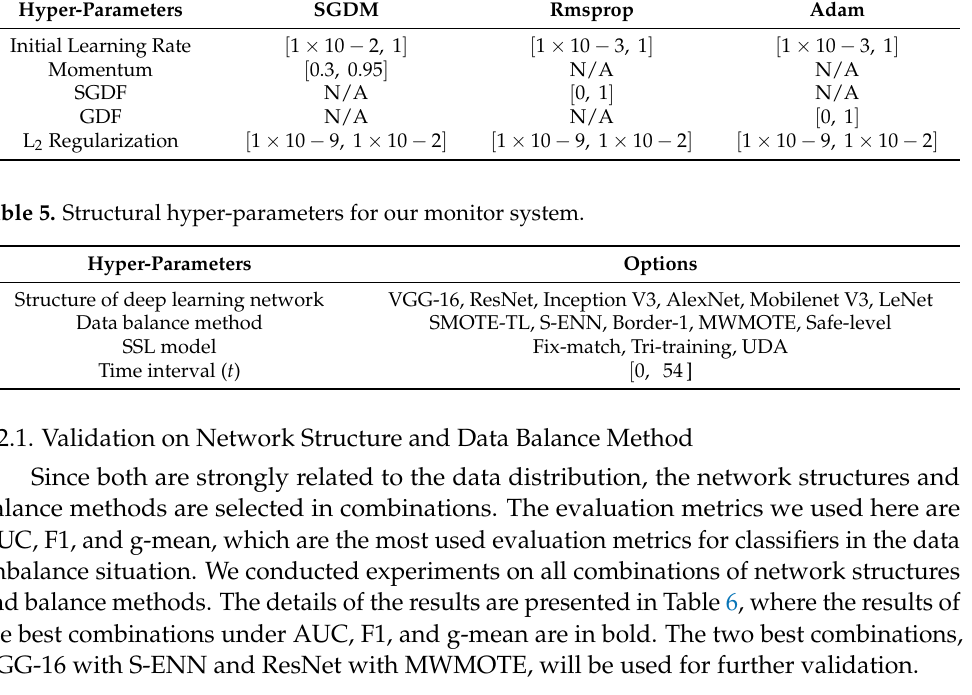
Table 4. Optimized hyper-parameters for optimizers and their search ranges. SGDM, Rmsprop, Adam are gradient-based model optimizers. Since different models and datasets require different parameter update rules, it is necessary to select the optimal optimizer. The optimal parameter combination for optimizers also needs to be selected by random search in a certain range, including the initial learning rate, momentum, SGDF, GDF, and L2 regularization.